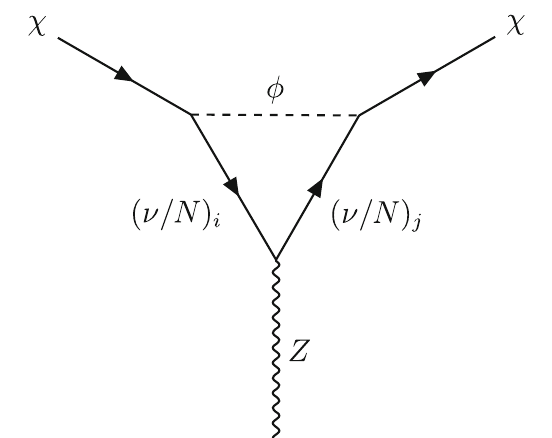
Fig. 6 1-Loop diagram generating the effective coupling of DM to the Z. The indices i , j run from 1 to 3